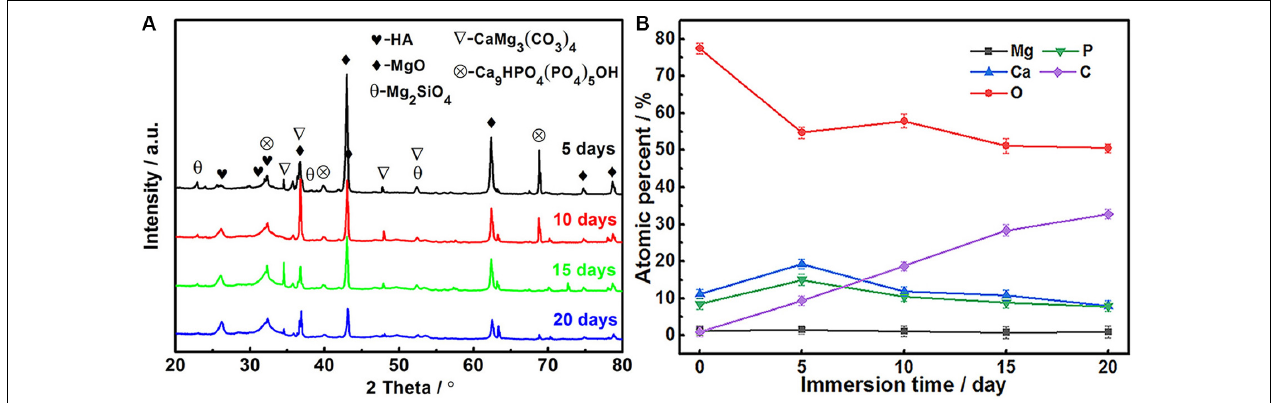
FIGURE 6 | XRD patterns (A) and element contents (B) of MAO-ED coating samples after different immersion days.